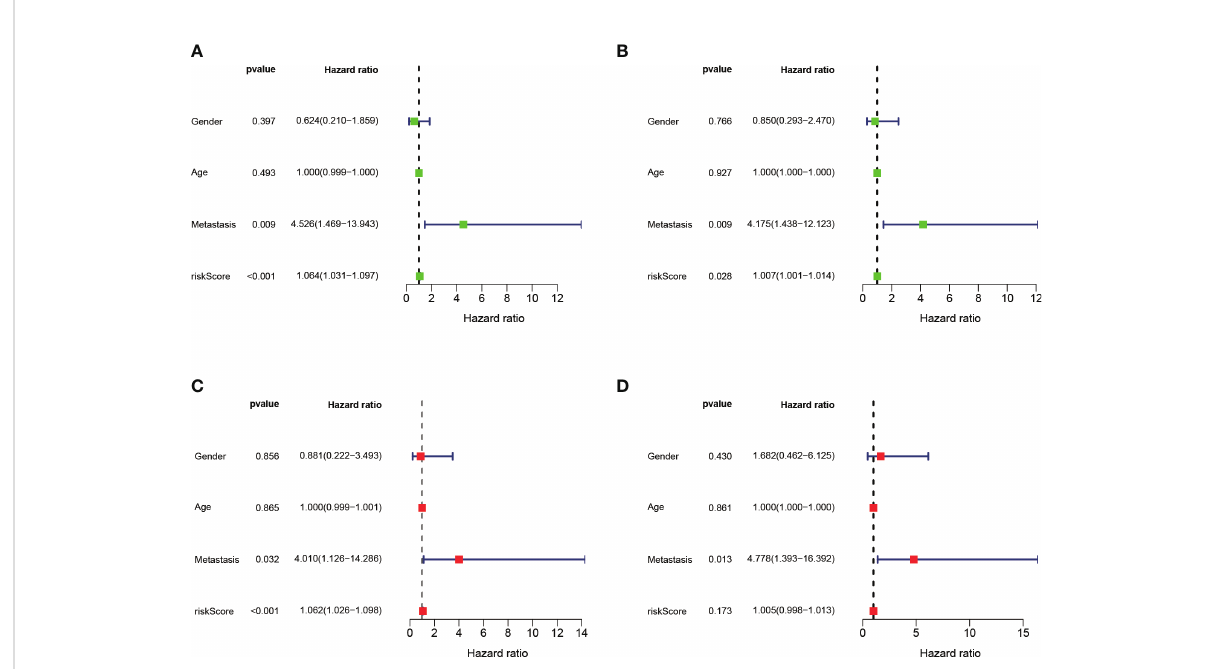
FIGURE 4 Independent prognostic analysis of the train and validation cohorts. (A) A forest plot conducted using univariate cox regression in the train cohort. (B) A forest plot conducted using univariate cox regression in the validation cohort. (C) A forest plot conducted using multivariate cox regression in the train cohort. (D) A forest plot conducted using Multivariate cox regression in the validation